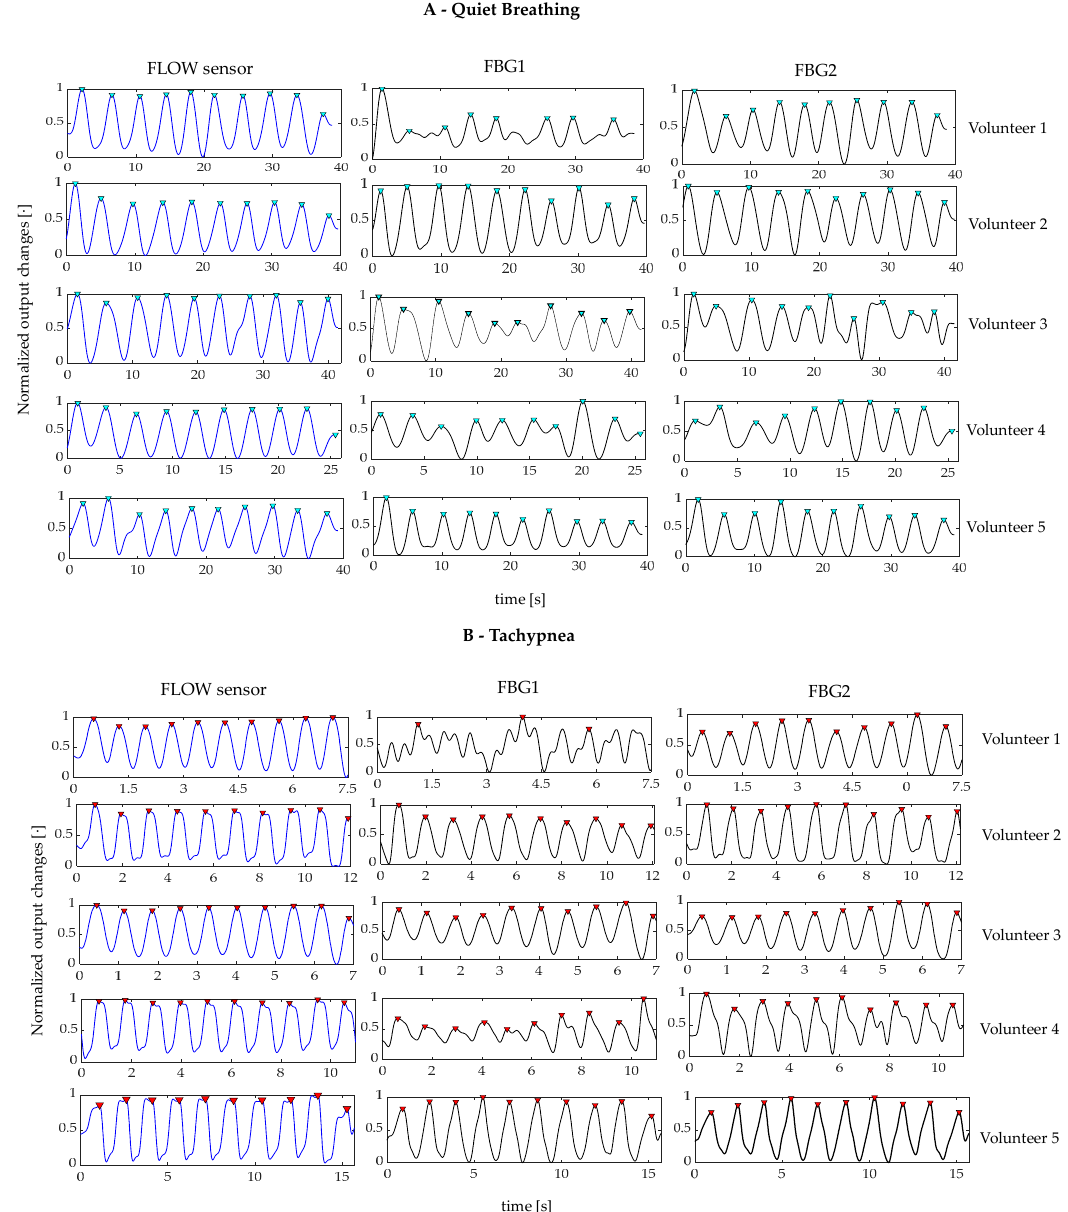
Figure 9. ( A ) signals collected by the flowmeter (blue line) and the FBGs (black lines) for each volunteer during quiet breathing and ( B ) during tachypnea. All the signals are synchronized, filtered, and normalized. The detected peaks are highlighted by using red markers.